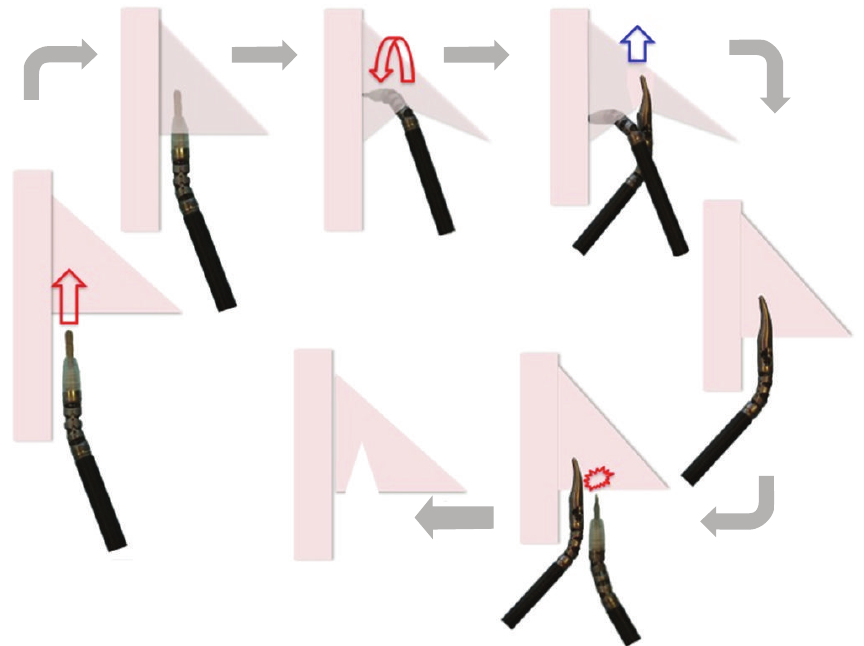
Figure 3: Stylopharyngeus cut sequence (from left, clockwise). The quadrangular shape represents the superior constrictor muscle and the triangular one the stylopharyngeus, right side. The aim is to completely cut the stylopharyngeus about 1cm lateral to the constrictor. First the Bowie is inserted dissecting between the prevertebral fascia and the stylopharyngeus muscle, parallel to the constrictor. With the tip of the Bowie resting on the fascia, the wrist of the instrument is turned upwards. This creates a space under the muscle. The Maryland is crossed under the Bowie to grasp the muscle with the jaws parallel to the constrictor. Finally, the Bowie is used to cut the muscle just lateral to the Maryland. The sequence can be repeated as many times as necessary to completely split the stylopharyngeus.